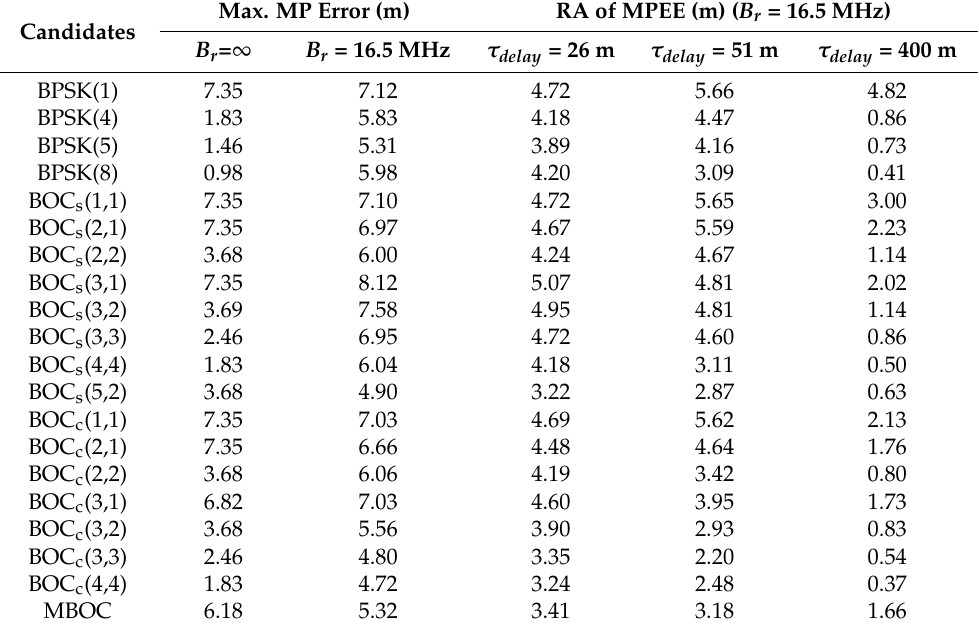
Figure 5. Multipath error envelope of the candidates in the S-band: ( a ) B r = ∞ ; ( b – d ) B r = 16.5 MHz. Table 9. Running average (RA) of the multipath error envelope (MPEE) of the candidates in the